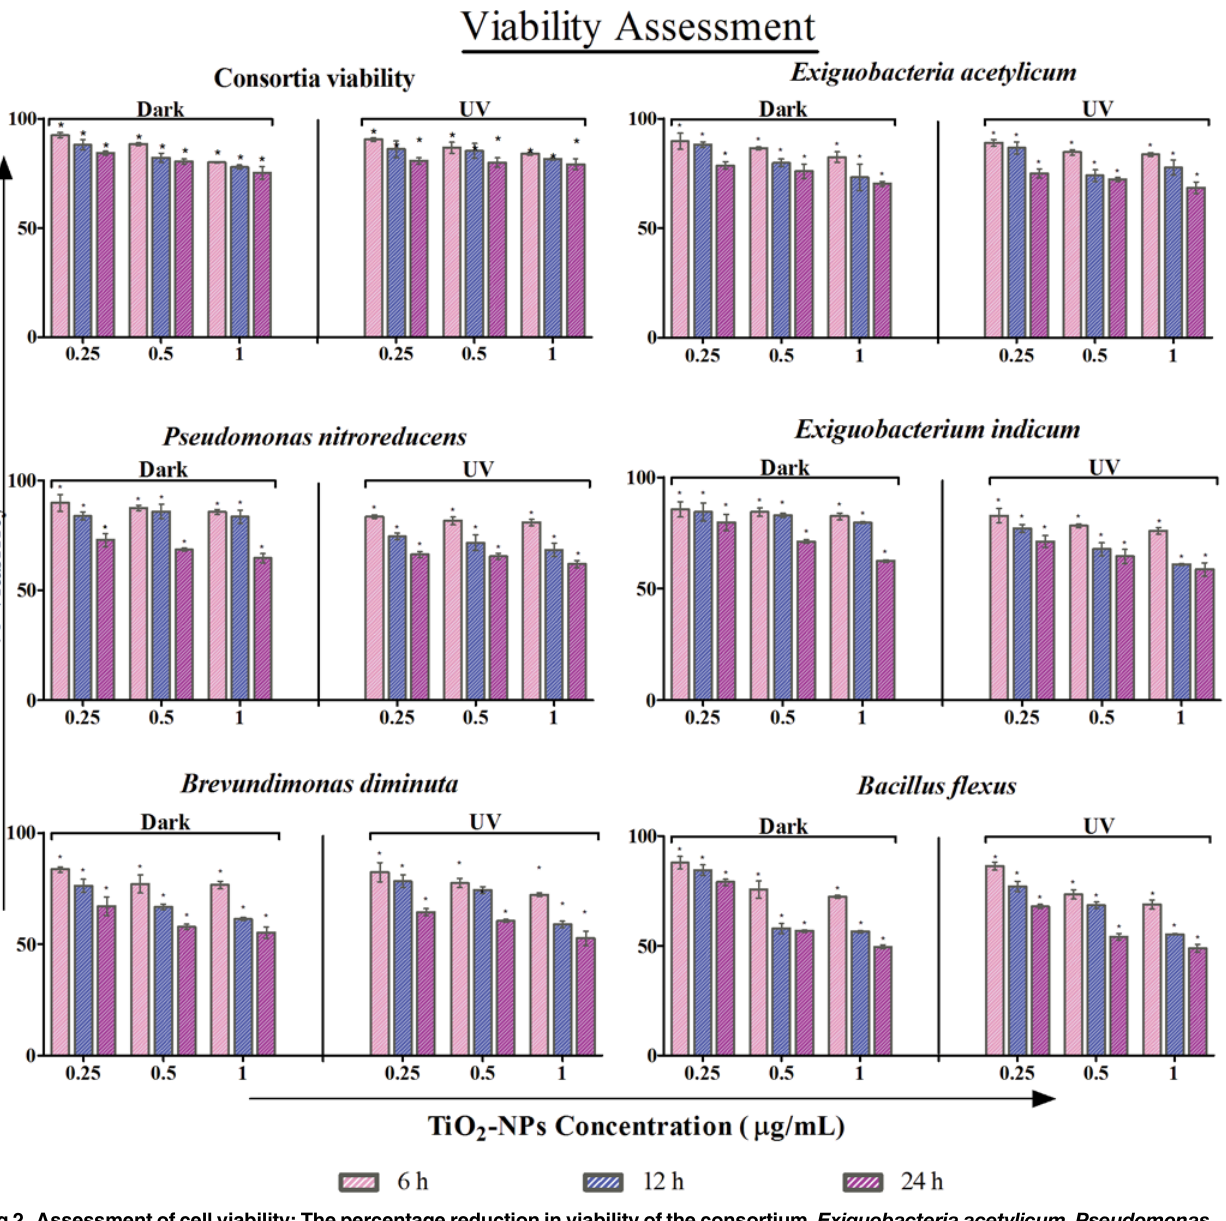
Fig 2. Assessment of cell viability: The percentage reduction in viability of the consortium, Exiguobacteria acetylicum , Pseudomonas nitoreducens , Exiguobacterium indicum , Brevundimonas diminuta and Bacillus flexus under dark and UVA condition at 0.25, 0.5 and 1 μ g/ml of TiO 2 -NPs (n = 3). Level of significance is represented with ‘ * ’ between treated cell with respect to control cell under dark and UVA conditions.